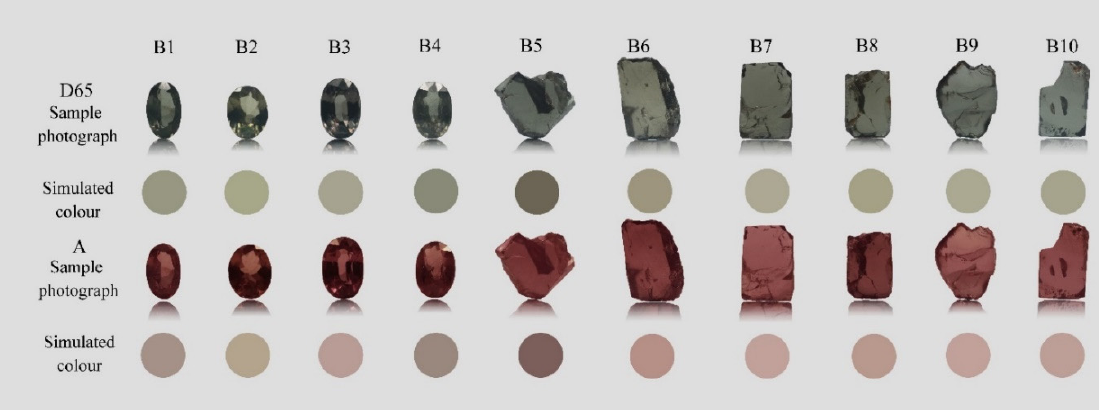
In the CIE1976 L*a*b* colour space, the difference in hue angle is often used to quantitatively evaluate the intensity of colour-changing effect. When the difference in the hue angle is greater than 20 ◦ , prominent changes in colour can be observed [14]. The 10 samples selected in this study exhibit significant change in colour with hue angle difference greater than 20 ◦ . Figure 7 shows the simulated colour block calculated by the colour matching functions. It had a high degree of reduction to the real colour of the sample.